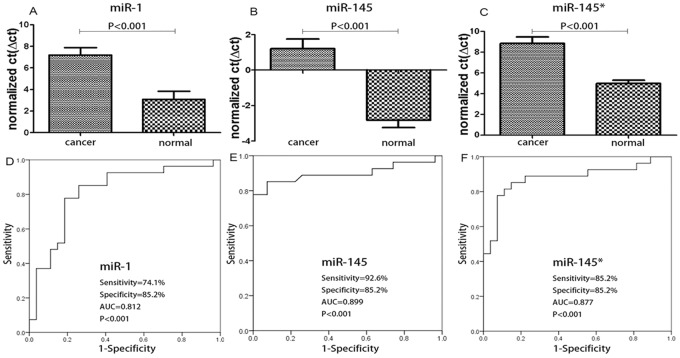
Evaluation of the potential of miR-1, miR-145, miR145* as cancer biomarkers.The results show that miR-1 miR-145 and miR-145* are likely good diagnostic markers with high sensitivity and specificity.